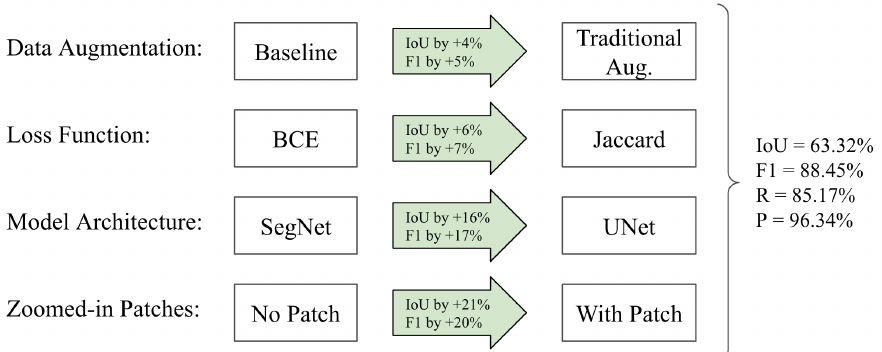
Figure 20. Summary of various approaches used to increase the accuracy of semantic segmentation of concrete